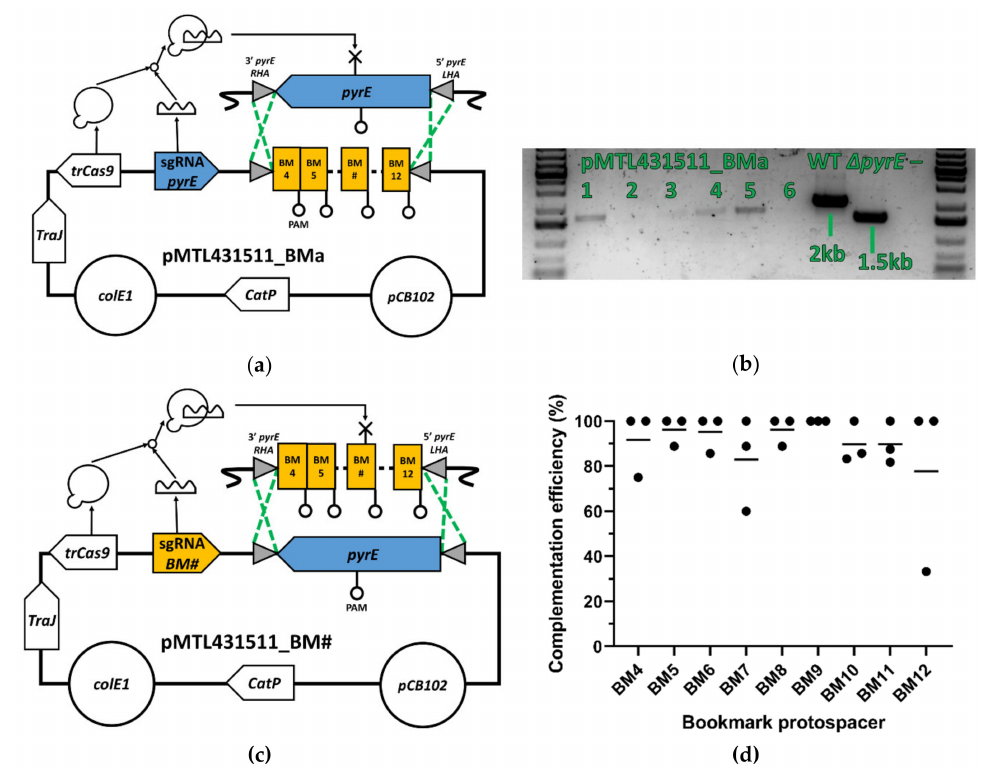
Figure 2. Proof of principle of the bookmark strategy. ( a ) Integration of an array of bookmark protospacers into the genomic locus of pyrE using pMTL431511_BMa. The bookmark protospacer array (BM4 to BM12) is flanked by two homology arms of 1 kb, each homologous to the genomic region directly upstream (LHA) and downstream (RHA) of the pyrE locus and which include the first two and last two codons of pyrE . Homology directed mutagenesis of the pyrE locus replaces the pyrE gene with the protospacer array. trCas9 nuclease and a sgRNA expression cassettes counter-select wild type (WT) transconjugants by cutting the genomic DNA of cells which have a WT pyrE locus. ( b ) Electrophoresis gel of six C. autoethanogenum colonies obtained after conjugation of pMTL431511_BMa. The pyrE locus of each colony was amplified using the primers oFS105 and oFS106 then run on a 1% (w / v) agarose gel. The expected size of the amplicon of a successfully knocked-in bookmark array (BMa) is 1.7 kb, versus 2 kb for the WT pyrE locus and 1.5 kb for a clean ∆ pyrE genotype without the bookmark array. No DNA template was added to the PCR mix of the negative control (–). ( c ) Integration of the pyrE gene back in its original locus using pMTL431511_BM# to target di ff erent bookmark protospacers. Each homology arm consists of a 1 kb region directly upstream (LHA) or downstream (RHA) of the pyrE locus, including the first two and the last two nucleotides of the pyrE gene, respectively. Together with the pyrE gene they constitute the pyrE editing template. trCas9 nuclease and sgRNA expression